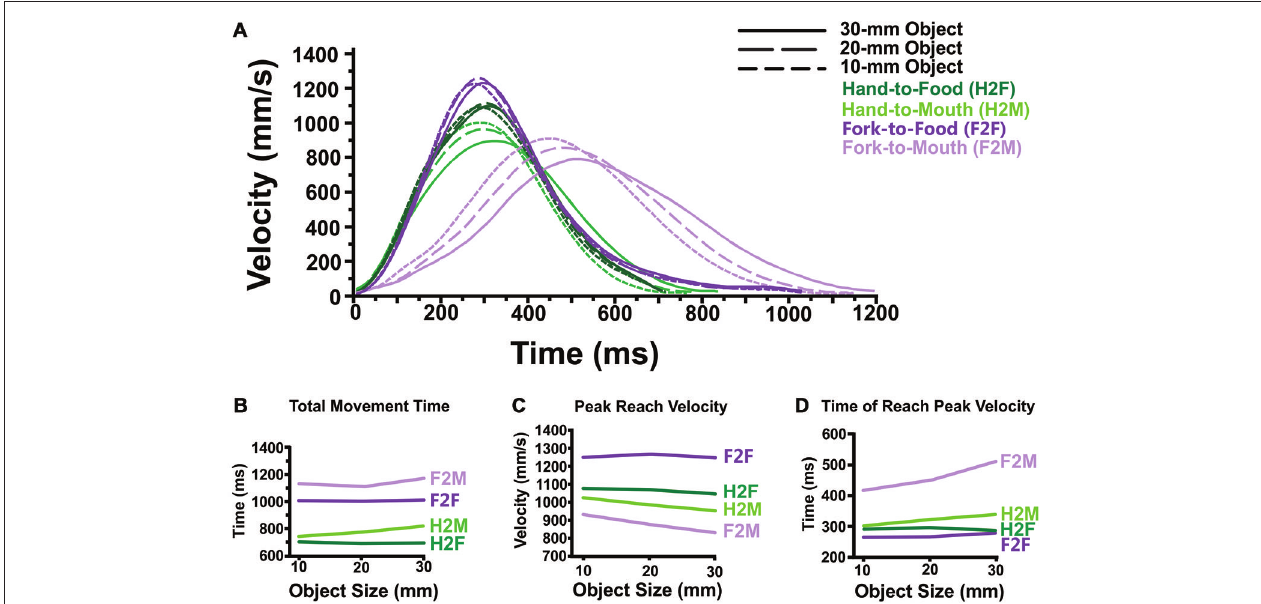
FIGURE 3 | Transport component results. (A) Averaged reach velocity profiles (as a function of absolute time, in ms) illustrate that Hand-to-Food , Hand-to-Mouth, Fork-to-Food and Fork-to-Mouth reaches display distinctly different transport patterns. (B) Reaches toward the mouth ( Hand-to-Mouth and Fork-to-Mouth ) take longer than reaches toward food items ( Hand-to-Food and Fork-to-Food ). Likewise, reaches performed with a fork ( Fork-to-Food and Fork-to-Mouth ) take longer to execute than those reaches performed with the hand alone. (C) Reaches directed toward the mouth ( Hand-to-Mouth and Fork-to-Mouth ) attain lower peak reach velocities than do reaches directed toward food items ( Hand-to-Food and Fork-to-Food ), regardless of whether the reach is performed by the hand alone or a fork. Also, mouth-directed reaches also become slower as object size increases, a pattern not seen in food-directed reaches. (D) Fork reaches directed toward the mouth ( Fork-to-Mouth ) attain peak velocity far later than all other reach conditions. Similarly, reaches toward the mouth in general ( Hand-to-Mouth and Fork-to-Mouth ) attain peak velocity later than reaches directed toward food items ( Hand-to-Food and Fork-to-Food ). Also, Fork-to-Food , Fork-to-Mouth and Hand-to-Mouth reaches each attain peak reach velocity later as object size increases.